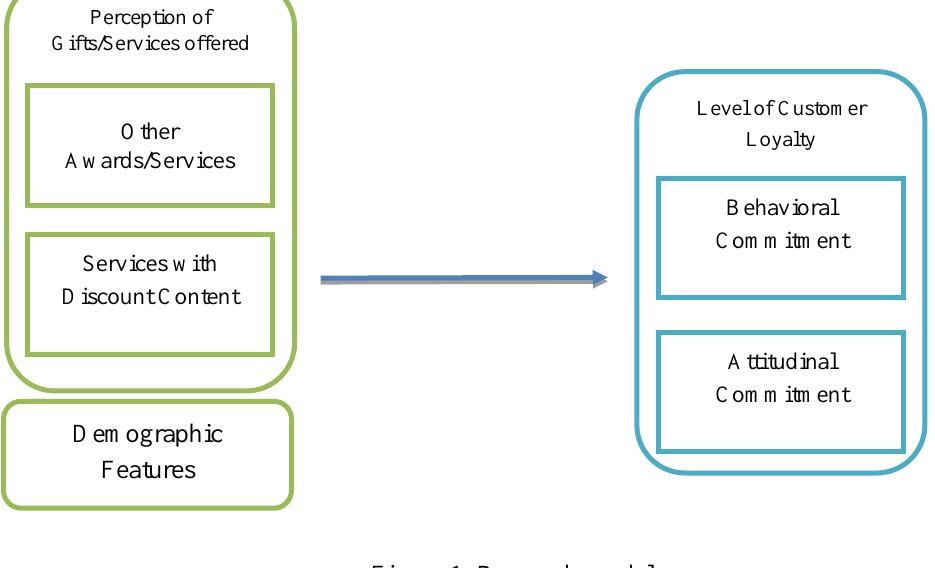
Figure 1. Research model